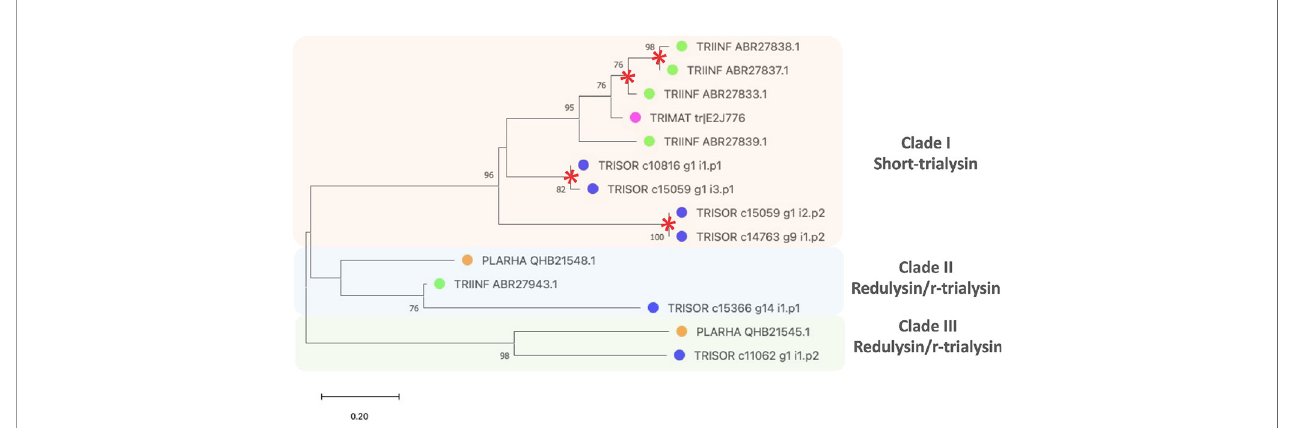
FIGURE 4 | The phylogenetic tree of trialysins from Triatoma sordida sialotranscriptome. The distance tree among trialysin sequences is derived from the alignment of T. sordida CDS extracted from the sialotranscriptome analysis and other trialysin sequences from Hemiptera (extracted from the non-redundant protein database of the NCBI applying PSI-BLAST algorithm) identi fi ed as described in Methods section. The colored circles identify the species whose sequences were used: blue, T. sordida ; magenta, Triatoma matogrossensis ; green, Triatoma infestans ; orange, P. rhadamanthus. Red asterisks indicate gene duplication events. The number at the nodes shows the bootstrap values. The scale on the bottom measure evolutionary distance in substitutions per amino